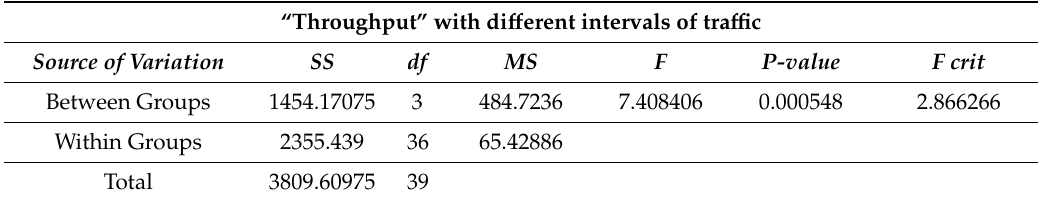
Table 7. ANOVA statistics of the proposed QCM algorithm in terms of “Throughput” scenarios. “Throughput” with di ff erent intervals of tra ffi